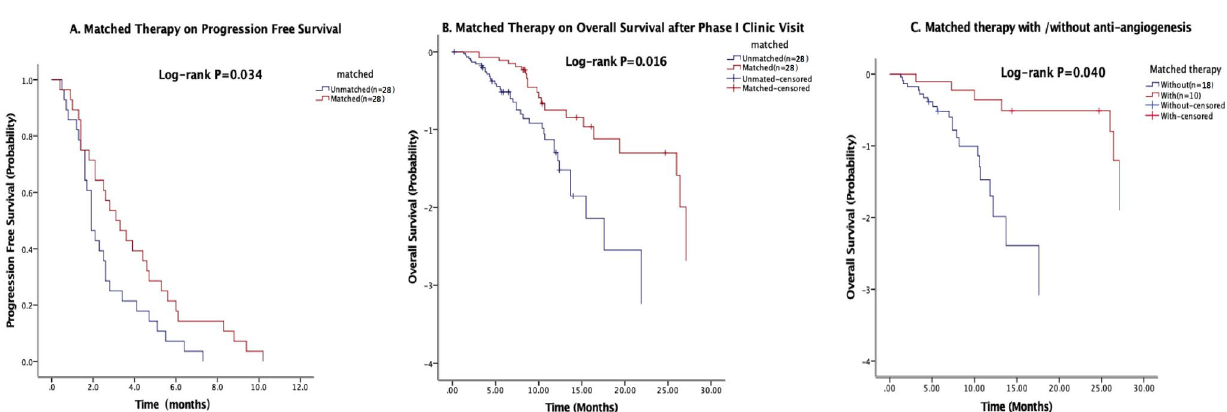
Figure 2. Kaplan–Meier curves estimate progression-free survivals in patients with CCNE1 amplification who received matched phase 1 trial therapy versus those who did not ( A ); Kaplan–Meier curves estimate overall survival after initial phase I trial clinic visit in patients with CCNE1 amplification who received matched phase 1 trial therapy versus those who did not ( B ); Kaplan–Meier curves estimate overall survival after initial phase I trial clinic visit in patients with CCNE1 amplification who received matched phase 1 trial therapy, stratified by anti-angiogenesis treatment ( C